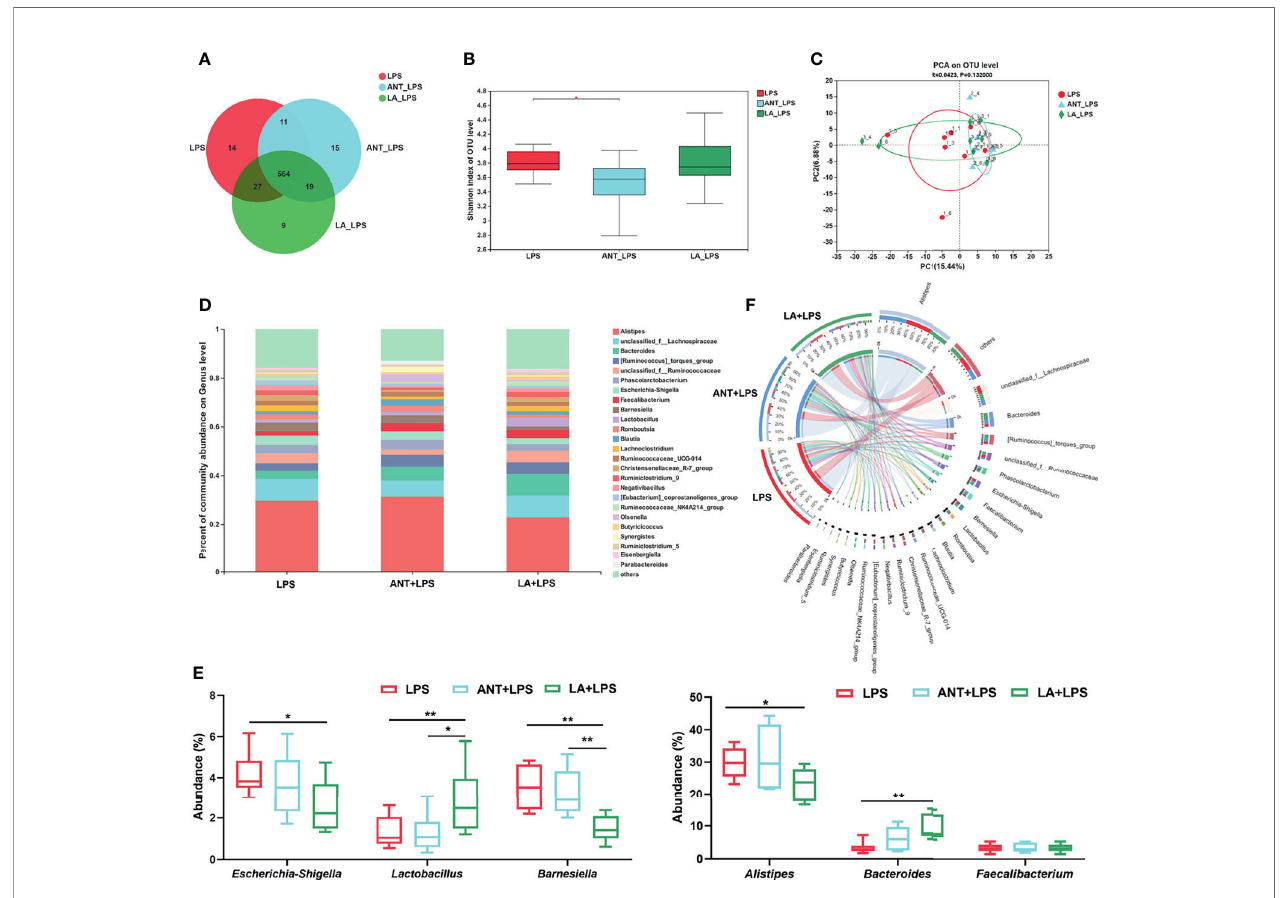
FIGURE 5 | Analysis of the diversity and composition of gut microbiota. LPS: fed with a basal diet and injected with 0.5 mg/kg LPS; ANT+LPS: fed with a basal diet supplemented with 75 mg/kg ANT, and injected with 0.5 mg/kg LPS; LA+LPS: fed with a basal diet supplemented with 1000 mg/kg LA, and injected with 0.5 mg/ kg LPS. N=8 in each group. (A) Venn diagram presenting the operational taxonomic units (OTUs) from each group. (B) Shannon index of OTU level re fl ecting the a diversity. (C) b diversity shown in a Principal component analysis (PCA) scatterplot. (D) Bar graph of microbial composition at the genus level. (E) Box plot of the signi fi cant genera among groups. (F) Circos diagram indicating the dominant genera in each group. The data were analyzed by one-way ANOVA and Tukey ’ s test. * P < 0.05, ** P <